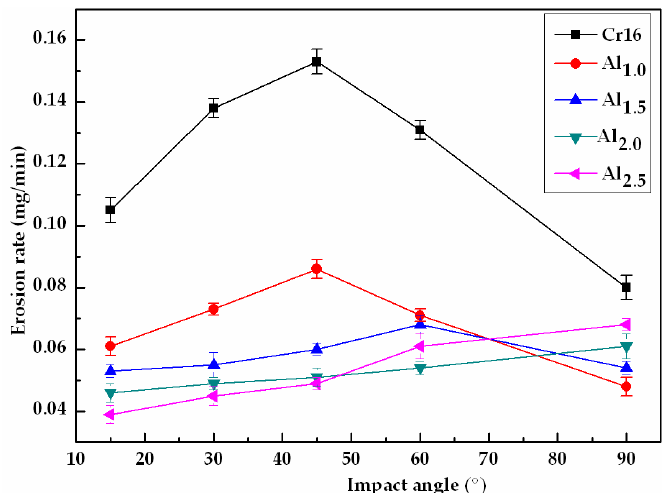
Figure 6. Variation in erosion rate of Al x CoCrFeNiTi 0.5 HEA coatings and Cr16 alloy with impact angle at a velocity of 10.08 m/s.